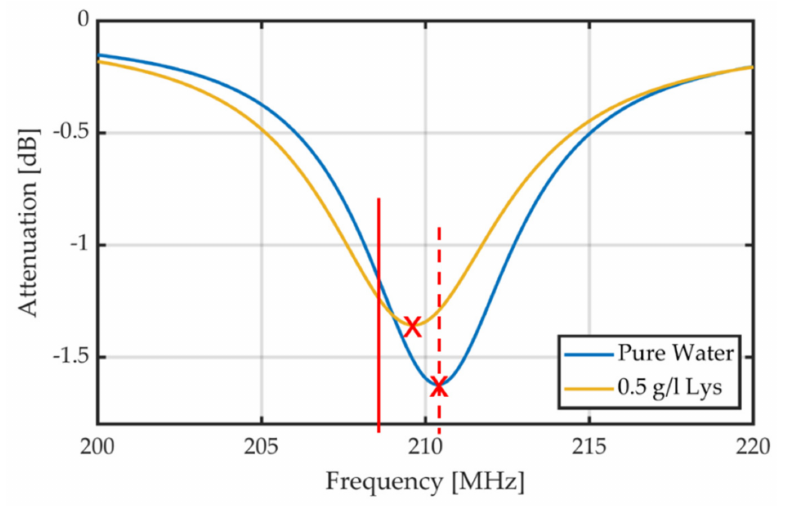
Figure 4. The three different evaluation methods visualized for 0.5 g/L Lysine (Lys) in UHPLC-MS grade water and UHPLC-MS grade water. 1. Tracking the resonance frequency is marked with a red crosses. 2. Measuring the attenuation at the fixed frequency defined by the resonance frequency for UHPLC-MS grade water is marked with a red dashed line. 3. Measuring the attenuation at the fixed frequency defined by the point with the highest slope with UHPLC-MS grade water is marked with a red solid